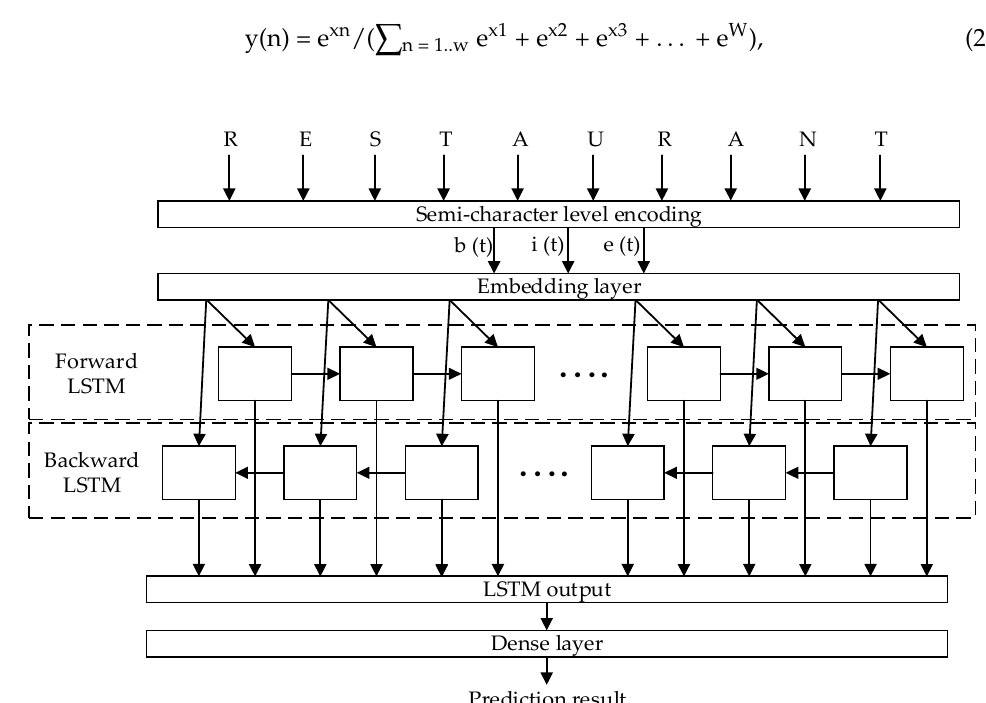
Figure 9. Recurrent neural network (RNN) proposed model.